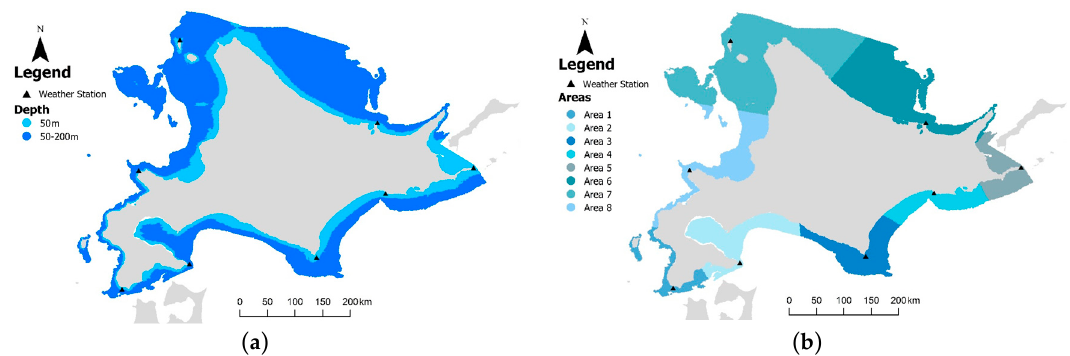
Figure 5. Suitable offshore wind locations in Hokkaido: ( a ) Divided into fixed-bottom (<50 m) and floating foundation suitable locations (50–200 m), and ( b ) divided into areas based on the weather station locations.